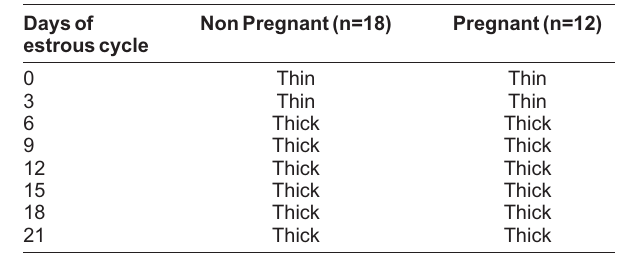
Table-3. Consistency of cervico-vaginal mucus in pregnant and non pregnant Thin- mucous flows easily from a slide